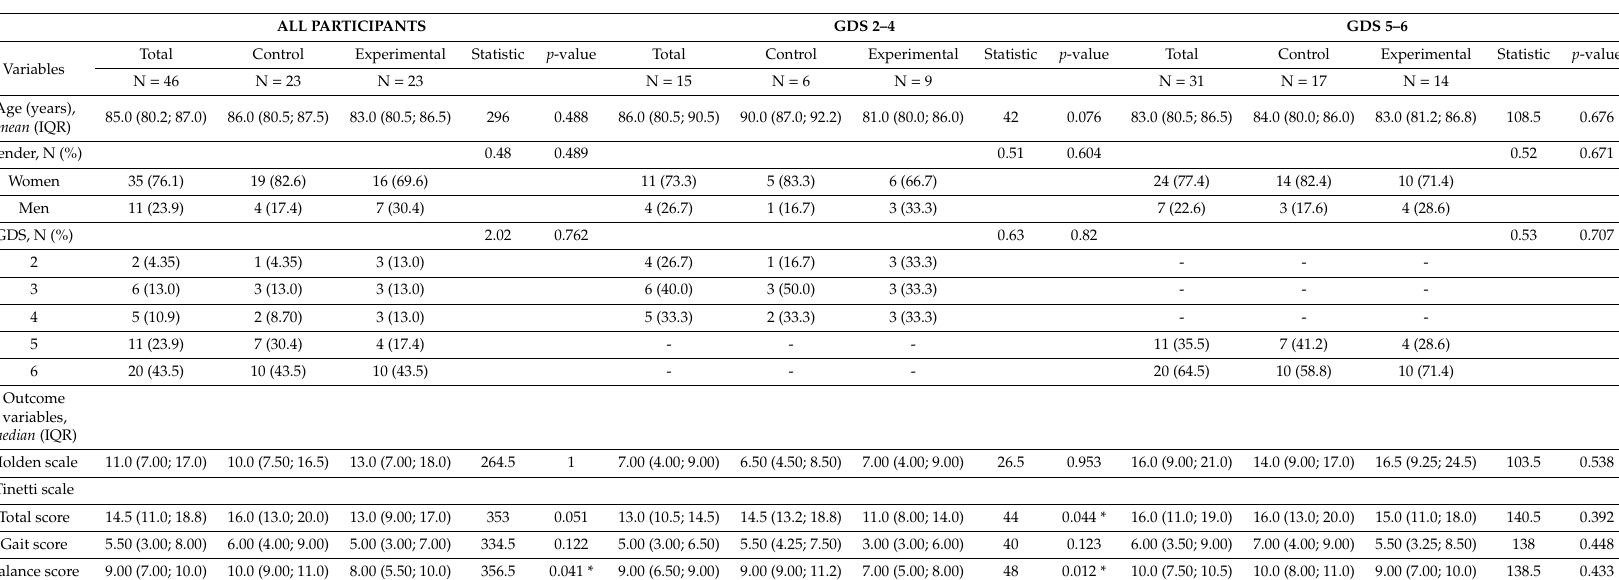
Table 1. Baseline demographic characteristics and clinical (preintervention)